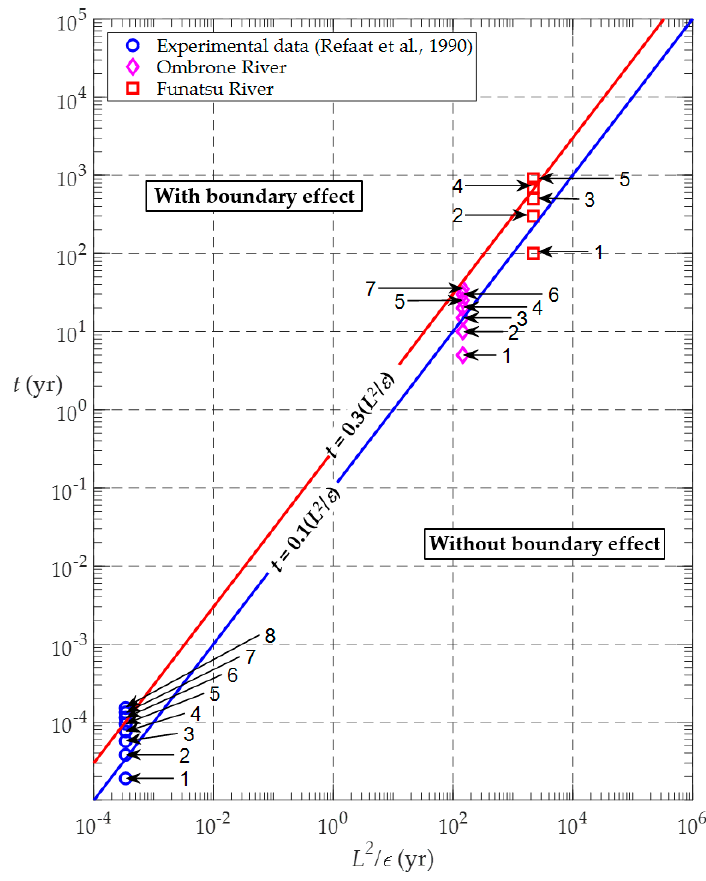
Figure 18. Demarcations for formation processes of river-delta shorelines.